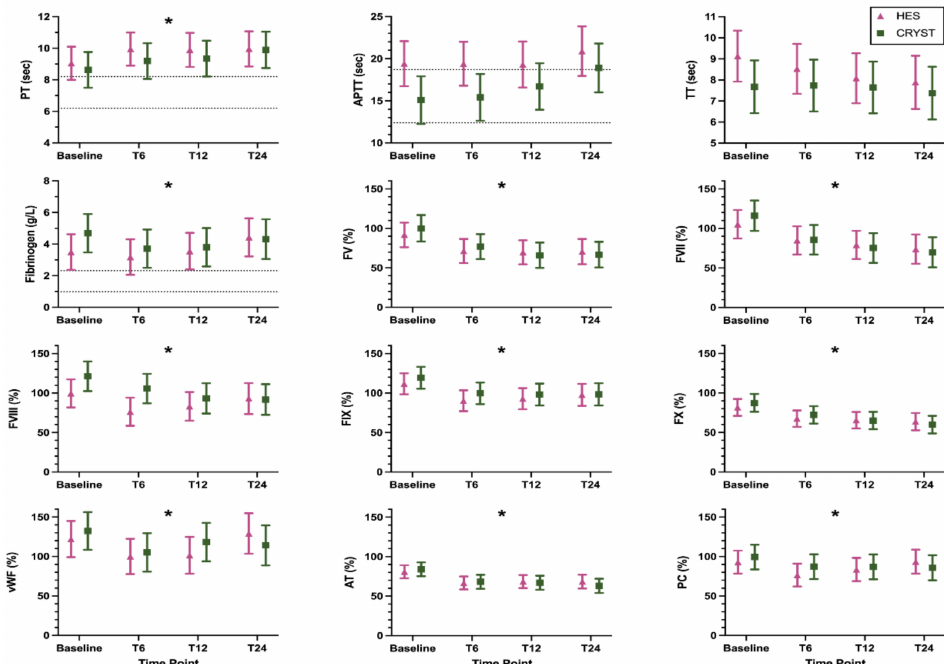
Figure 1. Coagulation biomarkers (mean, 95% confidence interval) in dogs randomized to receive 6% hydroxyethyl starch 130/0.4 (HES) or Hartmann’s solution (CRYST). Dotted lines indicate published reference intervals where available. * indicates a significant ( p < 0.05) change over time where both groups are considered together. Abbreviations: APTT, activated partial thromboplastin time; AT, antithrombin activity; FV, factor V activity; FVII, factor VII activity; FVIII, factor VIII activity; FIX, factor IX activity; FX, factor X activity; PC, protein C activity; PT, prothrombin time; TT, thrombin time; vWF, von Willebrand factor antigen.